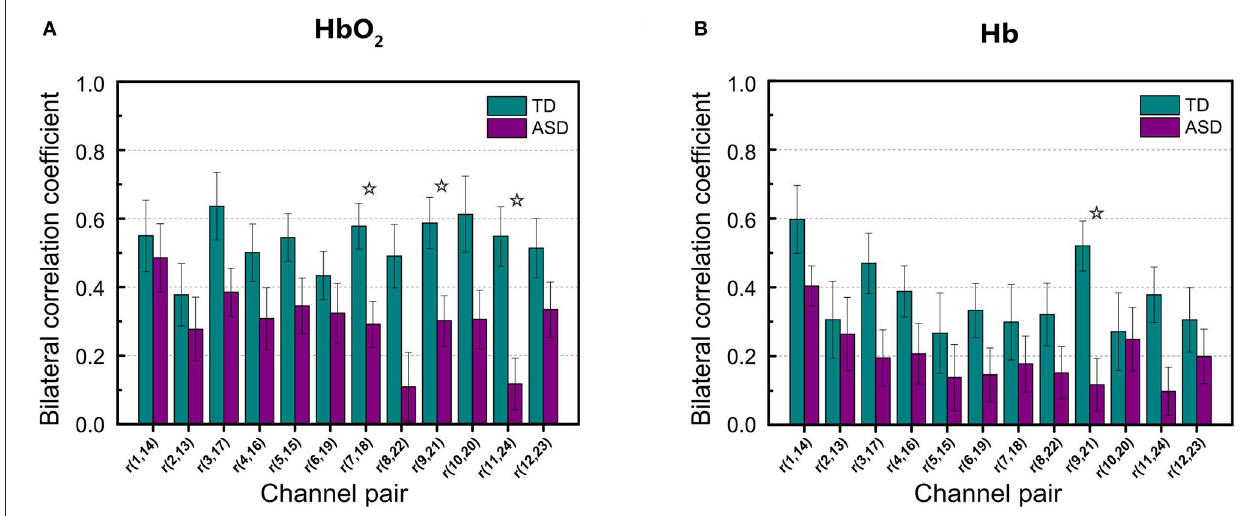
FIGURE 6 | Group average of the correlation coefficients in HbO 2 (A) and Hb (B) for each mirrored channel pair locating symmetrically on the left and right temporal lobes in Slow-5 band. The digit pair in the parenthesis indicates the corresponding channel pair, e.g., r (1,14) is the temporal correlation coefficient between channel 1 and channel 14. The asterisks indicate the differences in the correlation coefficient between ASD and TD are statistically significant (FDR-corrected q < 0.05) for the channel pair, and the statistical powers are larger than 0.8. The error bar for each correlation coefficient is the standard error of